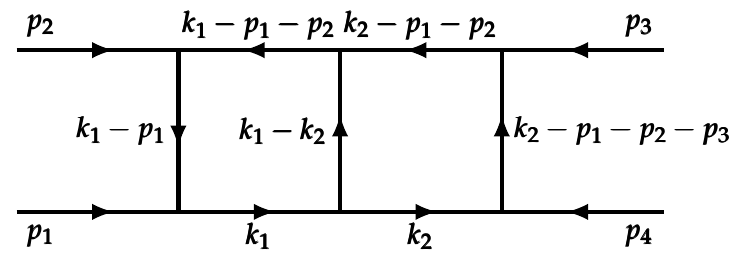
Figure 23. Double box diagram.